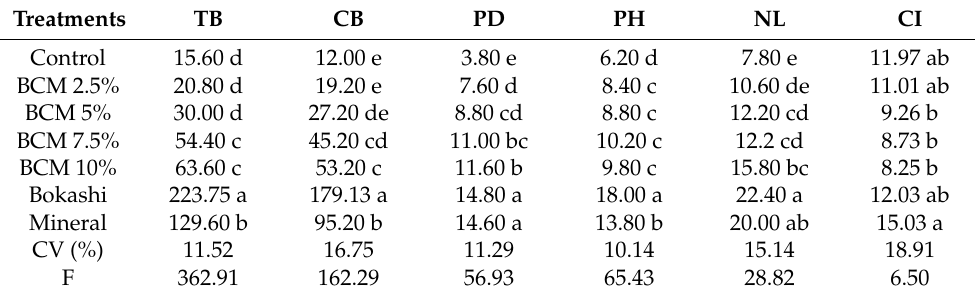
Table 2. Means of total biomass (TB) (g), commercial biomass (CB) (g), plant diameter (PD) (cm), plant height (PH) (cm), number of leaves (NL), and chlorophyll index (CI) (Falker index) in fris é e lettuce Brunella cv. submitted to different concentrations of boiled chicken manure (BCM), bokashi, and mineral fertilization in a greenhouse. Londrina, Paran á State, Brazil, 2020. Treatments